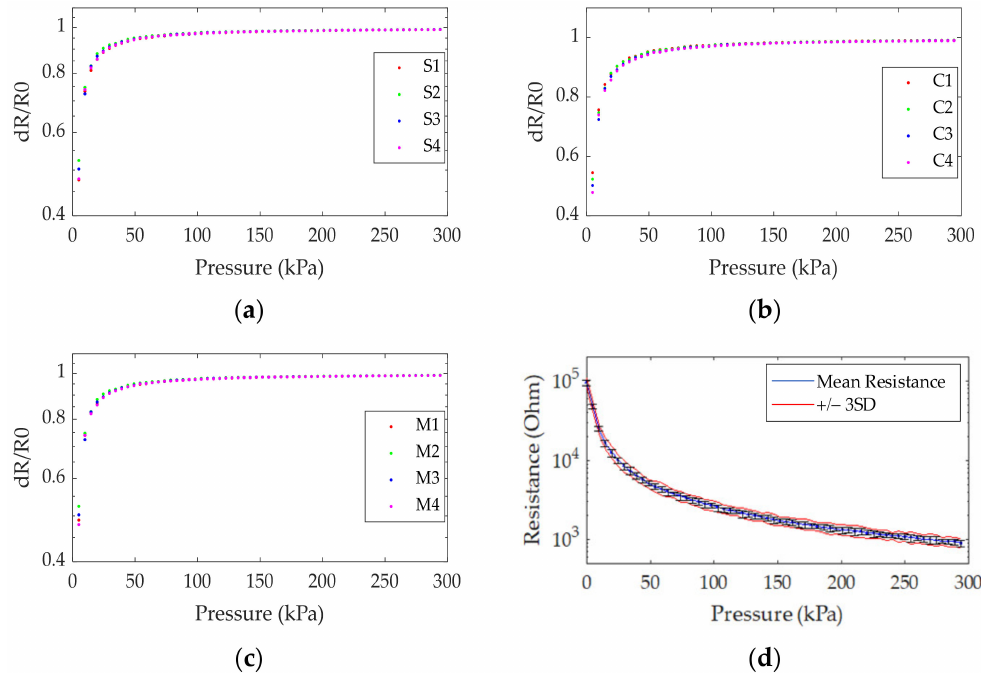
Figure 9. The resistance at different positions due to the pressure exerted: ( a ) sensor elements in the corners (C1, C2, C3, and C4); ( b ) sensor elements on the side (S1, S2, S3, and S4); ( c ) sensor elements in the middle (M1, M2, M3, and M4); ( d ) the average resistance of all groups.